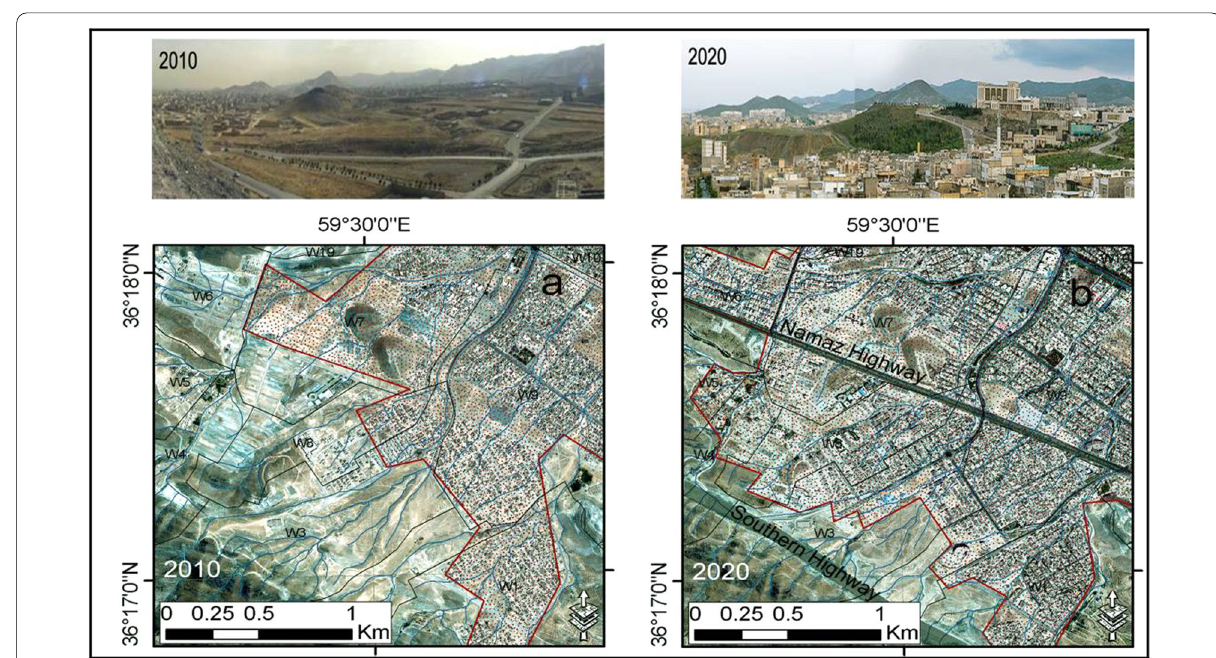
Fig. 5 Satellite imageries and general perspectives for a sample of the sprawl expansion in the study area for two time-windows a past time of 2010 and b present time of